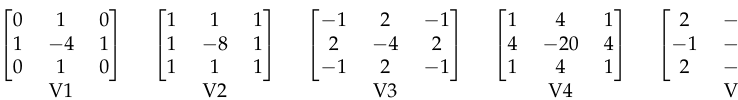
Figure A4. Laplace discrete approximation masks 3 × 3.